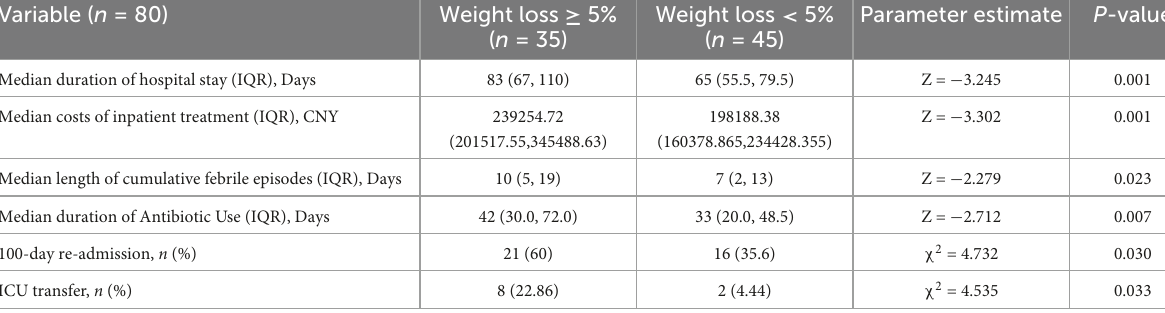
TABLE 3 Post-transplant clinical outcomes relative to weight loss after transplantation.